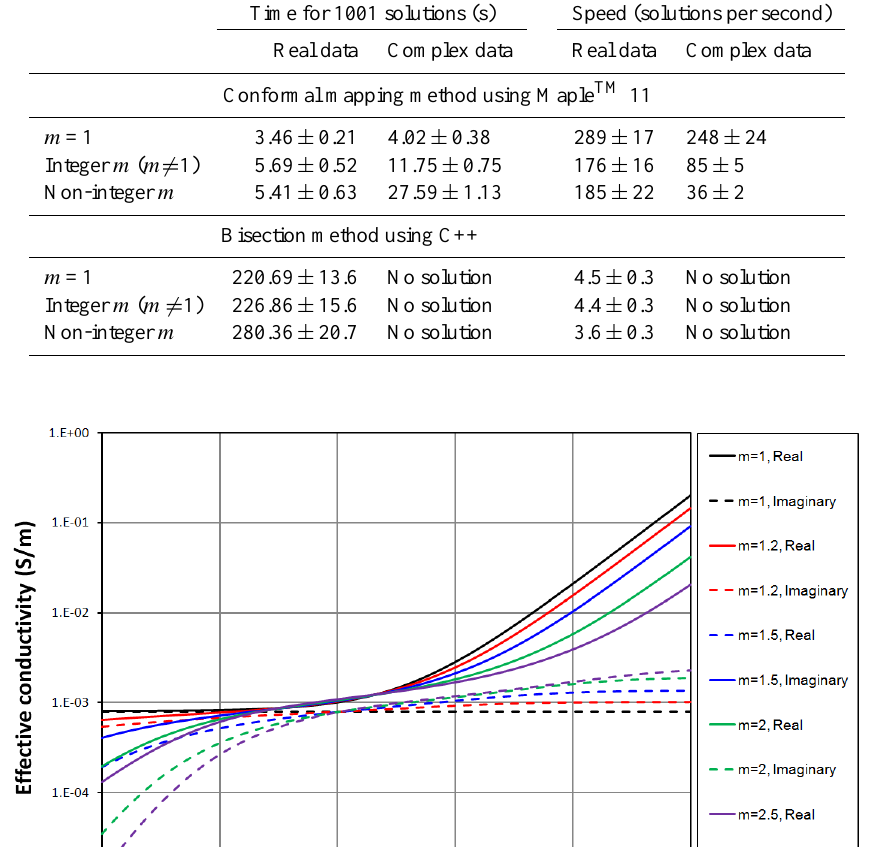
Table 2. Timing tests (mean over 12 runs ± standard deviation).